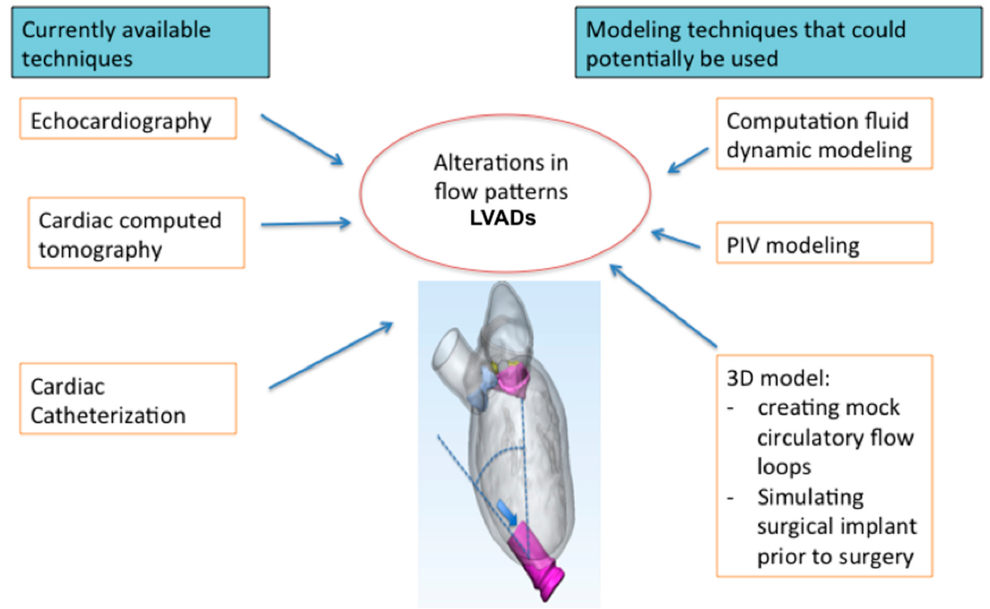
Figure 1. An elaboration of the currently available imaging modalities and modeling techniques that could be potentially employed in the future study of left ventricular assist device (LVAD).